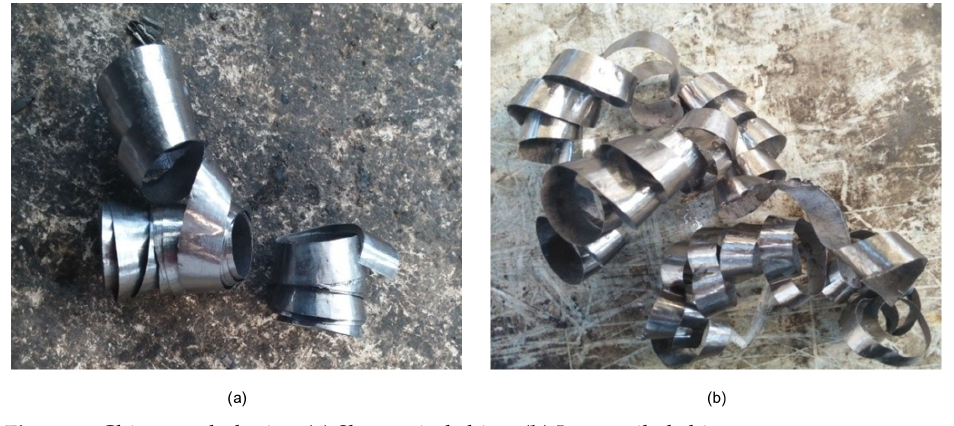
Figure 5. Chip morphologies. ( a ) Short spiral chips. ( b ) Long coiled